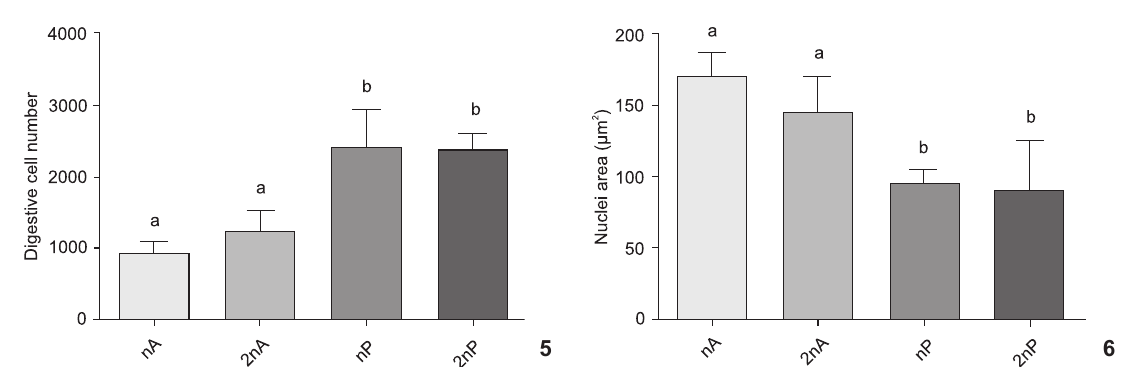
Figures 5-6. Number and nuclear area (µm 2 ) of digestive cells of haploid (nP) and diploid (2nP) pupae males and haploid (nA) and diploid (2nA) adult males of Melipona quadrifasciata anthidioides. Vertical bars denote standard error. Different letters indicate significant differences in: (5) the number of digestive cells per 0.414 mm 2 of midgut area; and (6) the nuclear